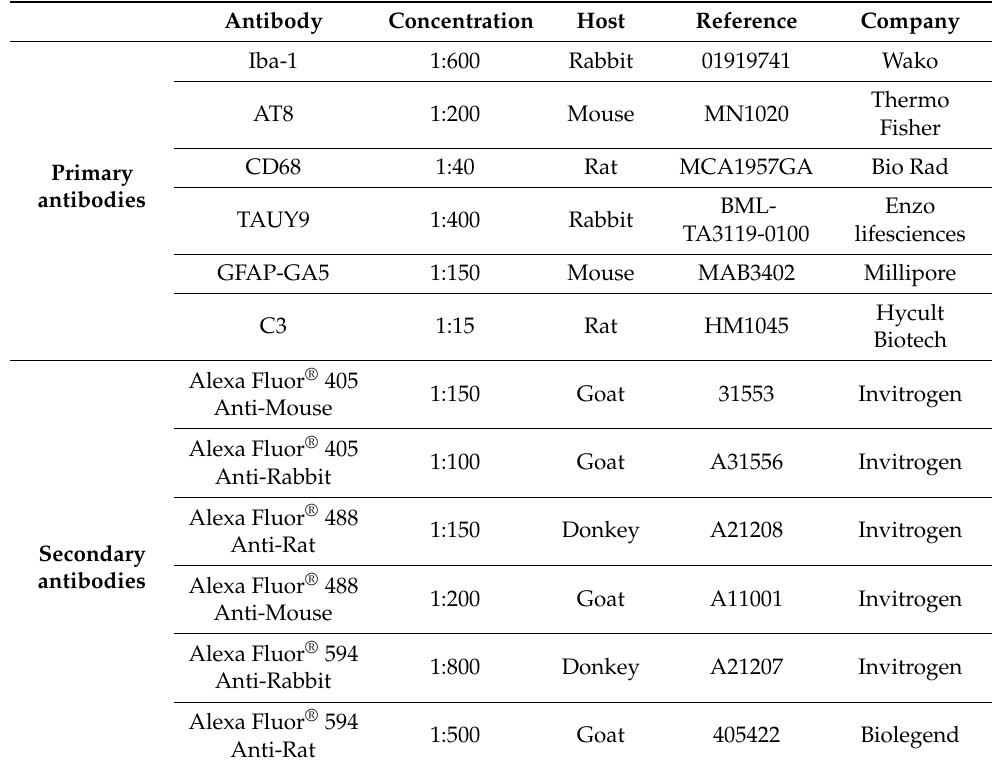
Table 1. Antibodies employed for the immunostaining analysis and their corresponding